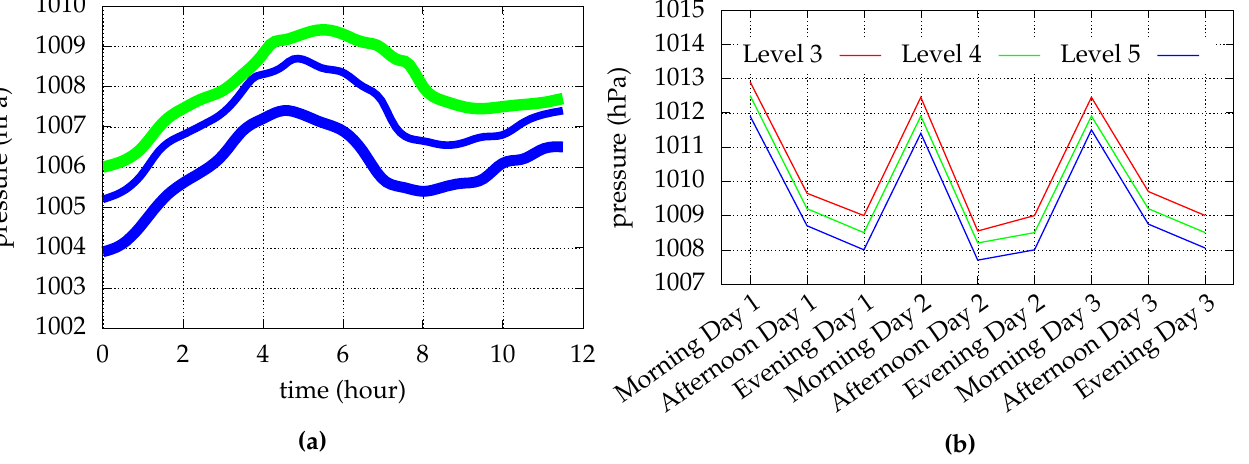
Figure 1. Recordings of absolute pressure readings for two scenarios. (a) 12 hour pressure trend on a single floor using a Galaxy S3 (green) and two Nexus 4 (blue). The width of the lines describes the uncertainty of the measurements. (b) Recordings of three pressure readings on three different levels at 3 different times across 3 different days. The figures are based on the datasets provided by [9]. on an object. Therefore, as altitude increases, atmospheric pressure decreases accordingly.